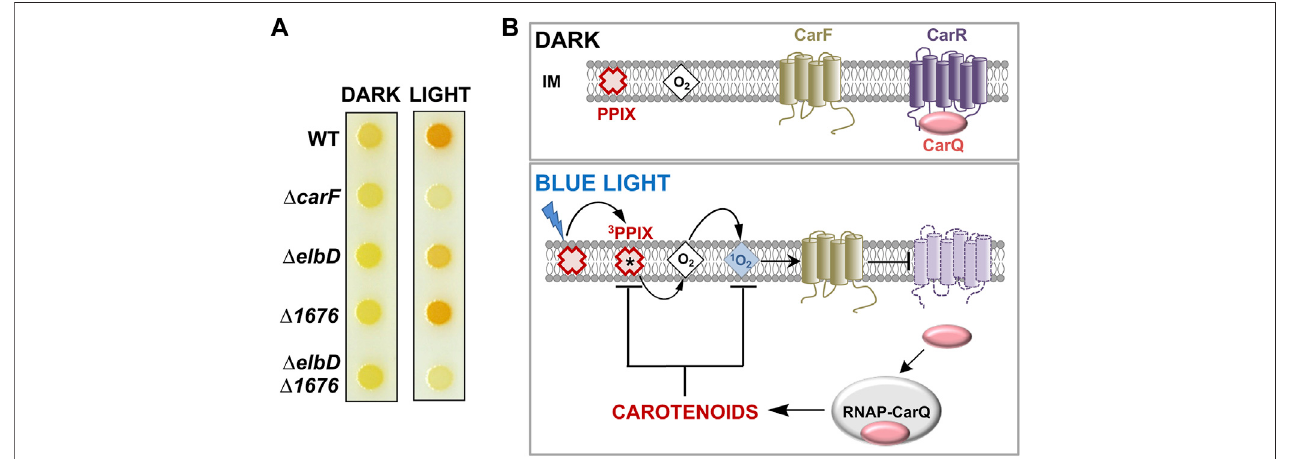
FIGURE 4 | Light response in M. xanthus . (A) M. xanthus colony color in the dark and in the light in the wild-type strain (WT) and with various indicated deletions (adapted from (Gallego-García et al., 2019)). (B) Simpli fi ed model for the blue light-PPIX- 1 O 2 signal transduction pathway in M. xanthus . In the dark, an inner membrane (IM) anti- σ factor (CarR) with a six transmembrane-helix topology sequesters its cognate σ factor (CarQ). Blue light excites protoporphyrin IX (PPIX), the iron-free heme precursor and photosensitizer, to the high-energy 3 PPIX state, from which energy transfer to O 2 generates highly reactive 1 O 2 , which requires CarF to inactivate CarR by an unknown mechanism. This leads to the release of CarQ, which associates with RNA polymerase (RNAP) to activate speci fi c genes enabling the synthesis of carotenoids to quench reactive 1 O 2 and 3 PPIX and limit photooxidative damage (black arrows: activation; blunt-ended arrows: inactivation).